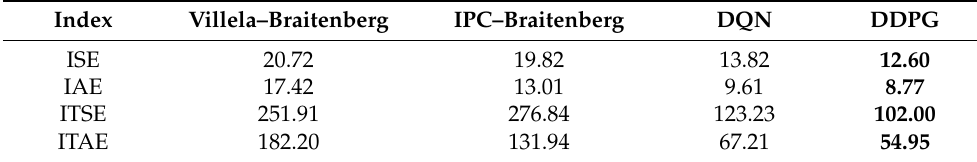
Table 9. Average performance indices (three target points) in the experiment with